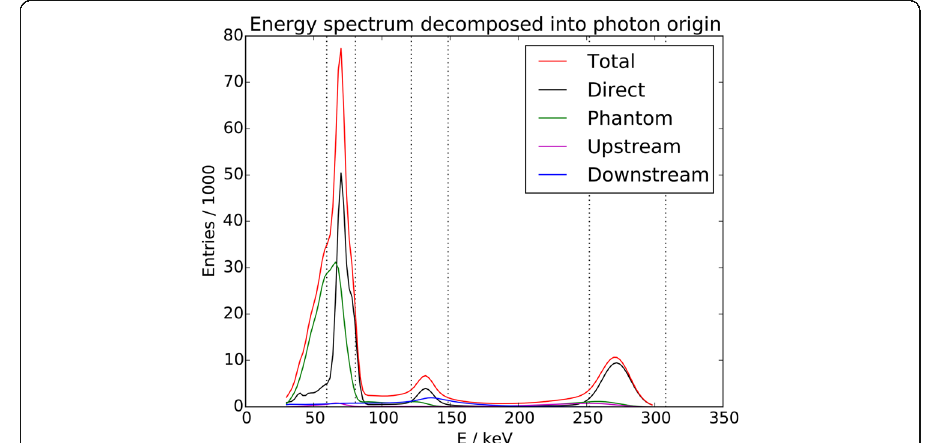
Fig. 5 Scatter origins. Energy spectrum simulated in tomographic setup decomposed into direct and inelastically scattered photons. Scatter volumes are classified as phantom (phantom, table), upstream (collimator, crystal cover), or downstream (light-guide, backscatter compartment, shielding). Energy windows are marked as dotted vertical